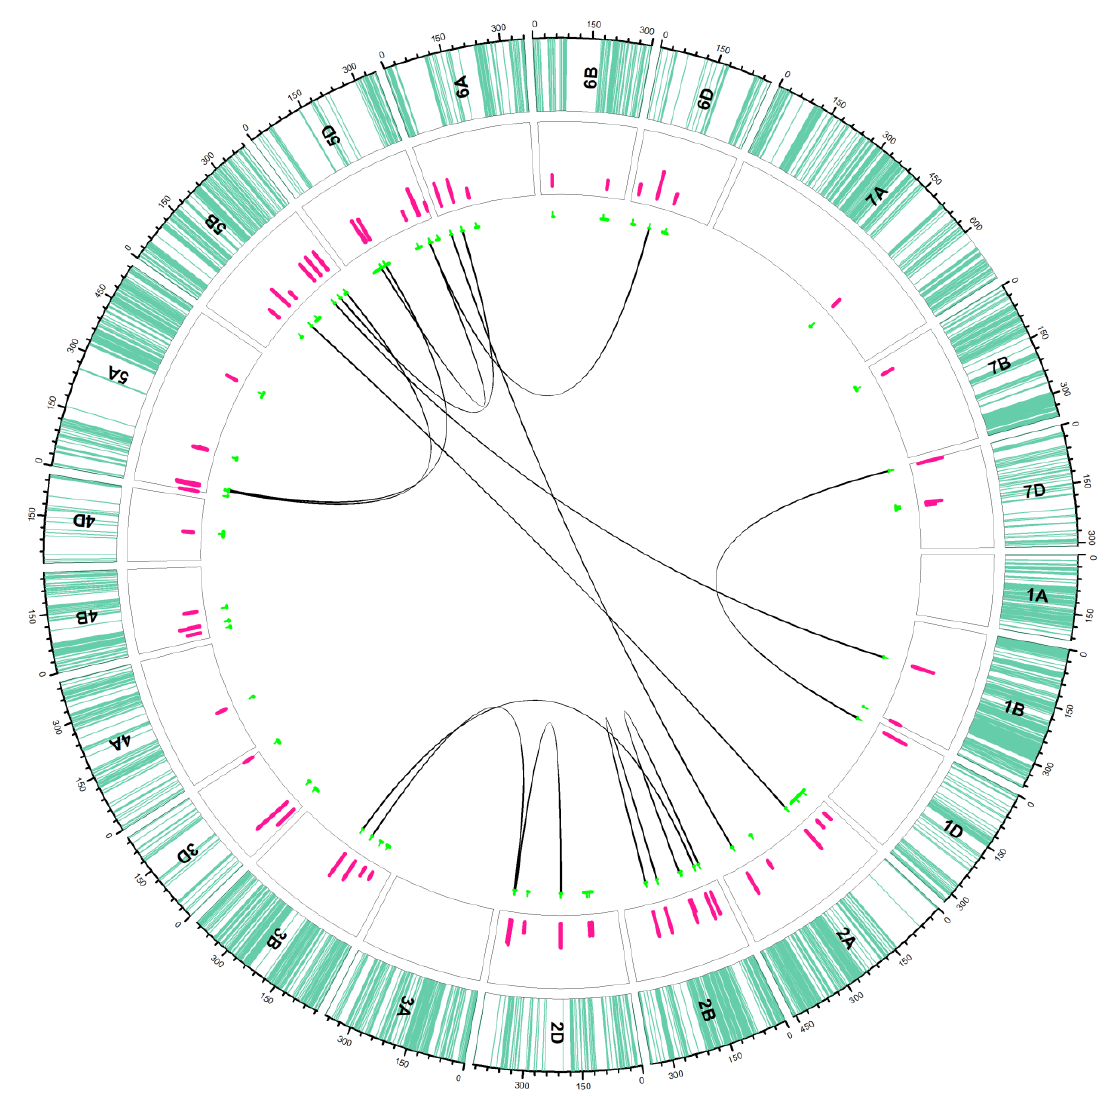
Figure 2. Distribution of additive (unconnected green lines in the inner circle) and epistatic (connected green lines in inner circle) QTLs in the ITMI/MP. Sea green lines in the outer track indicate the SNP positions on each chromosome; pink bars in the second circle indicate the LOD values of QTLs. The green lines under the track circle indicate the confidence interval of QTLs with small vertical lines point to the peak position of QTL. The black lines linked different biallelic epistasis QTLs. For details, see Tables 2 and 3.